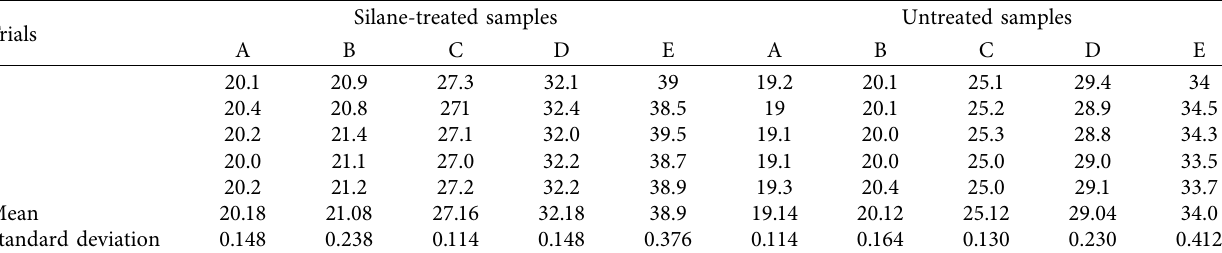
Table 4: Flexural test results of an epoxy composite.